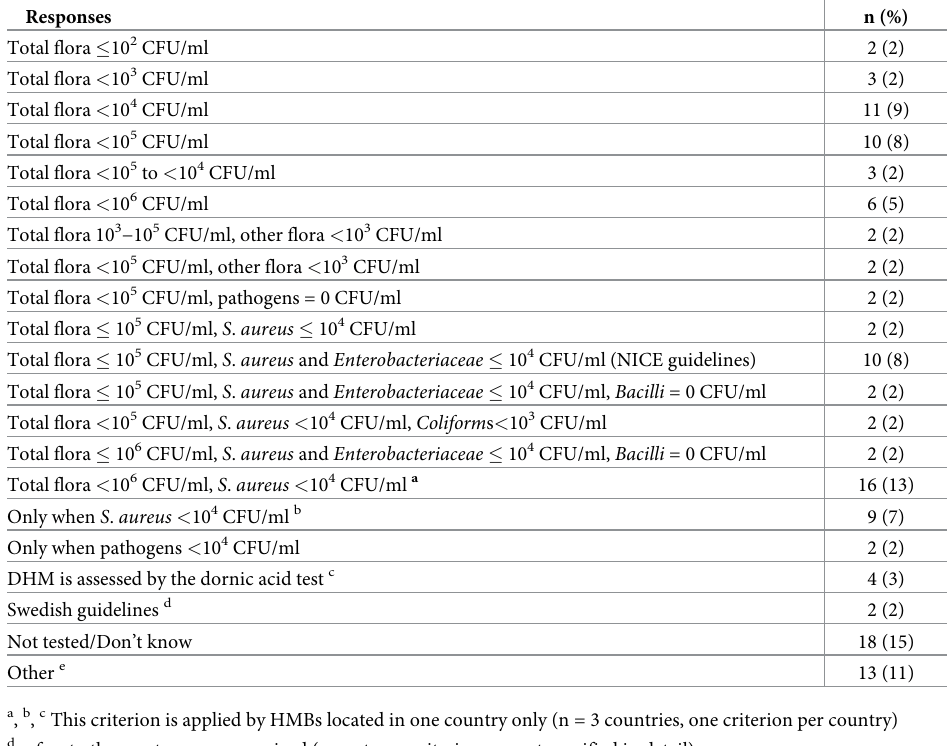
Table 3. Microbiological criteria defining DHM acceptability before pasteurization (n =